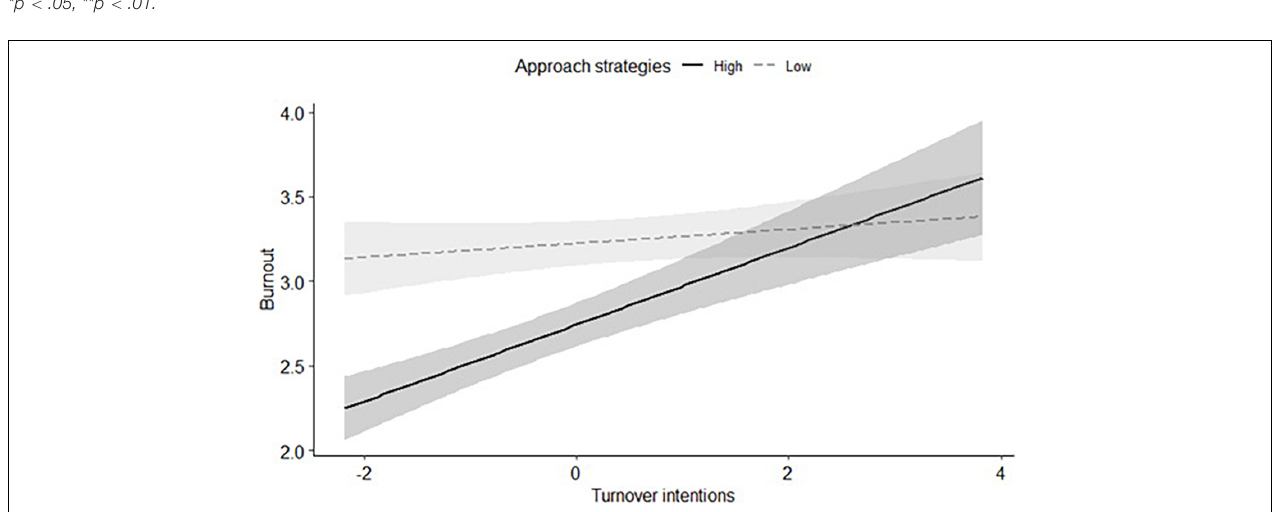
FIGURE 1 | Burnout as a function of turnover intentions and approach coping strategies (means in the high and low groups are estimated based on ± 1 SD from the